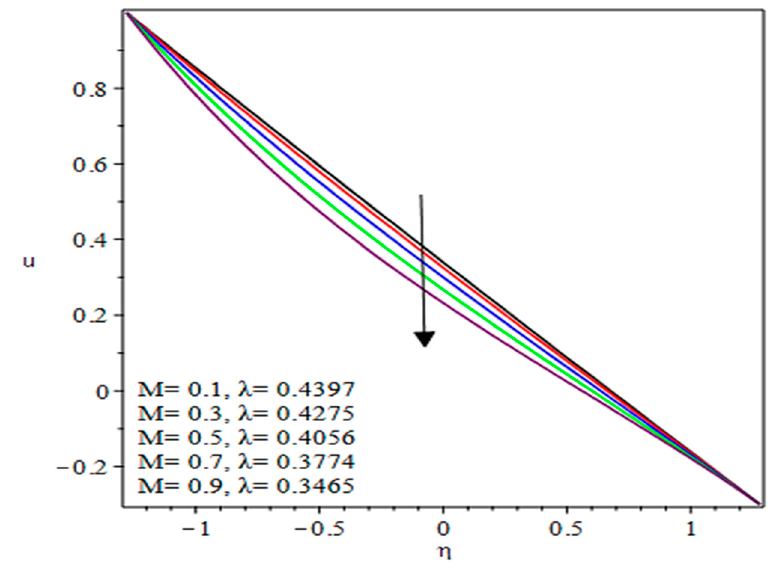
ξ= 0.75 by fixing = 0.1 K